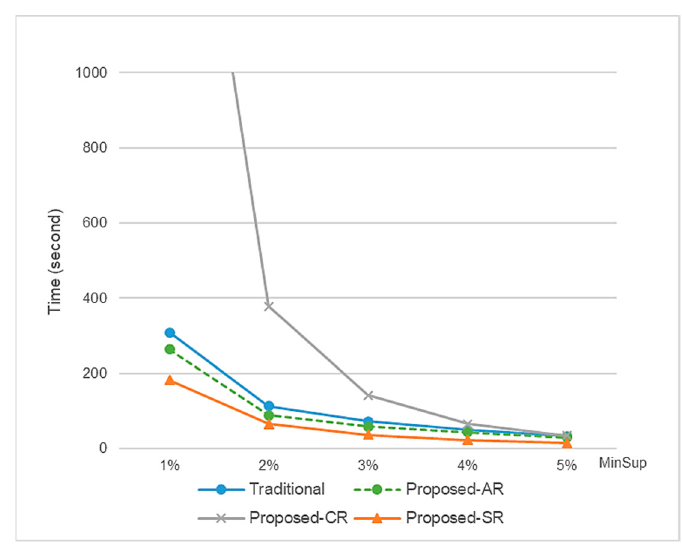
Figure 3. The performance comparison of level of anomalies ( left ) and number of final rules ( right ).